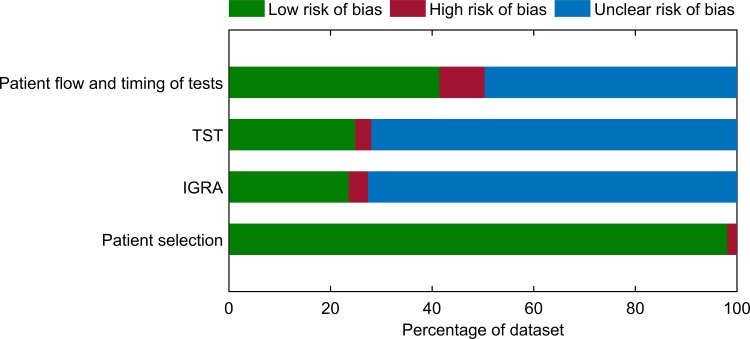
Summary of quality assessment results.Risk of Bias of each QUADAS-2 domain presented as percentages across the 157 included studies. IGRA; interferon-gamma release assay; TST, tuberculin skin test.